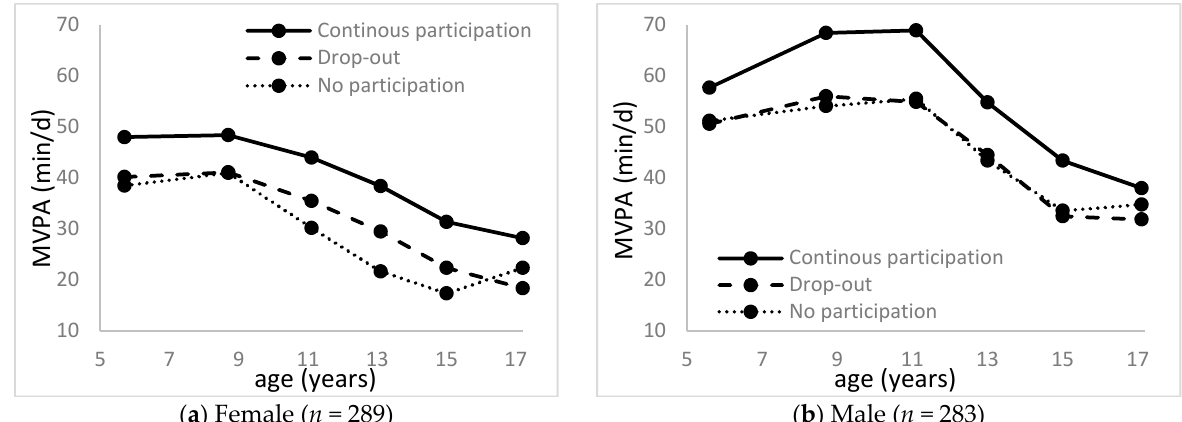
Figure 2. Moderate- and vigorous-intensity physical activity (MVPA) during childhood by youth sports participation patterns: (1) female and (2) male.